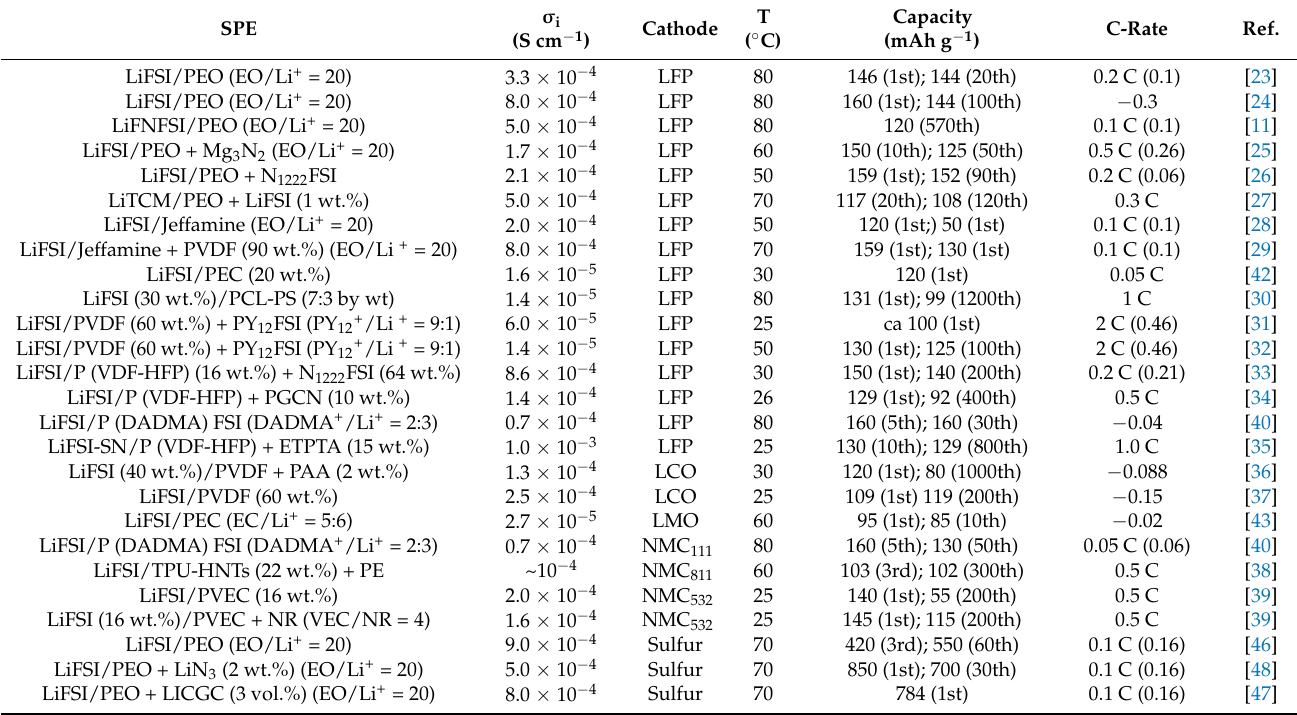
Table 1. Electrochemical performance of lithium batteries using FSI-based SPEs. σ i is the conductivity at temperature mentioned in the 4th column. Current density is expressed in C-rate with equivalent in mA cm − 2 in